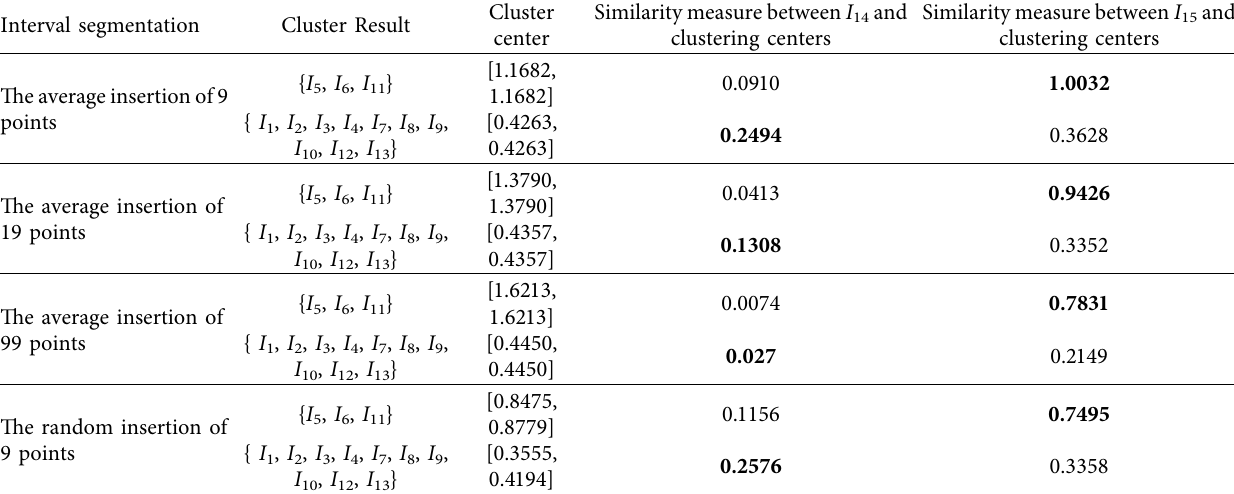
Table 6: Similarity measure between the implication operator and cluster